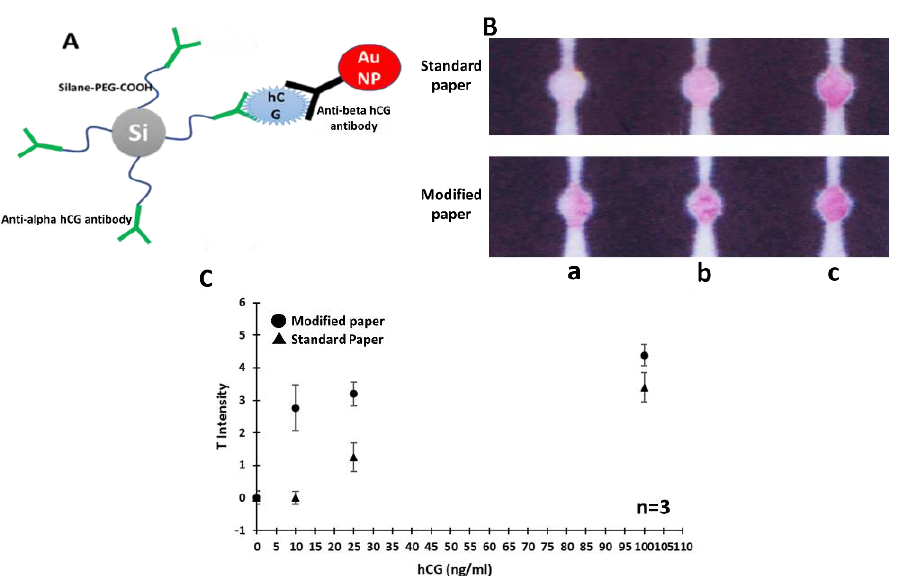
Figure 4. ( A ) Schematic representation of the sandwich structure of Silane composite − cap − ture antibody − (hCG − probe complex). ( B ) Photographs of µ PADs made with standard and modified filter paper in detection of hCG samples with three different concentrations (a: 10, b: 25, c: 100 ng/mL). ( C ) Semi-quantitative analysis of the obtained signal intensity from the tested µ PADs. The error bars represent the standard deviations corresponding to the average values (n = 3).